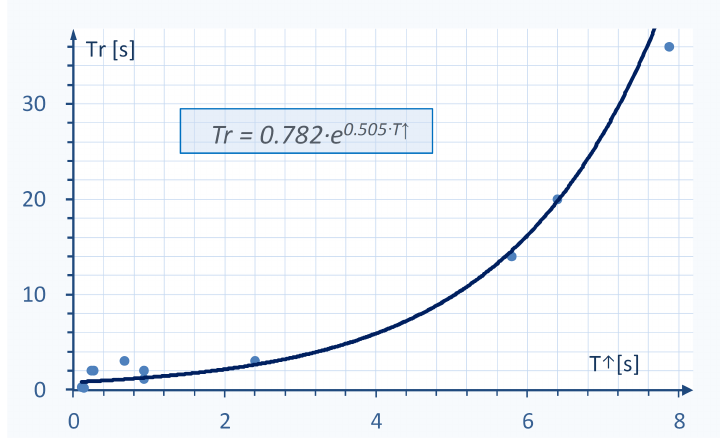
Figure 16. The ramp time constant, T r , versus the time constant, T ↑ .